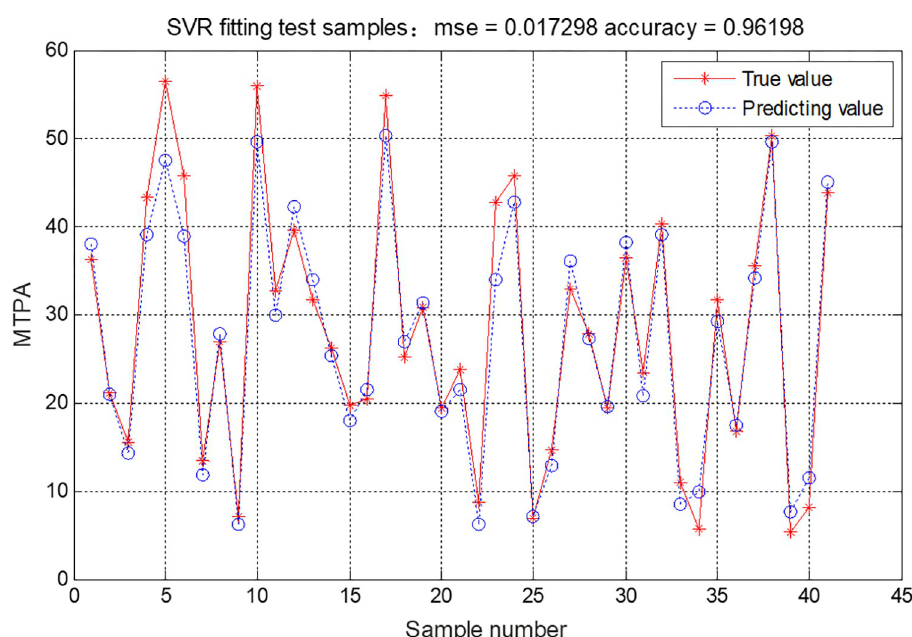
Fig 7. Predicting results of SVR.